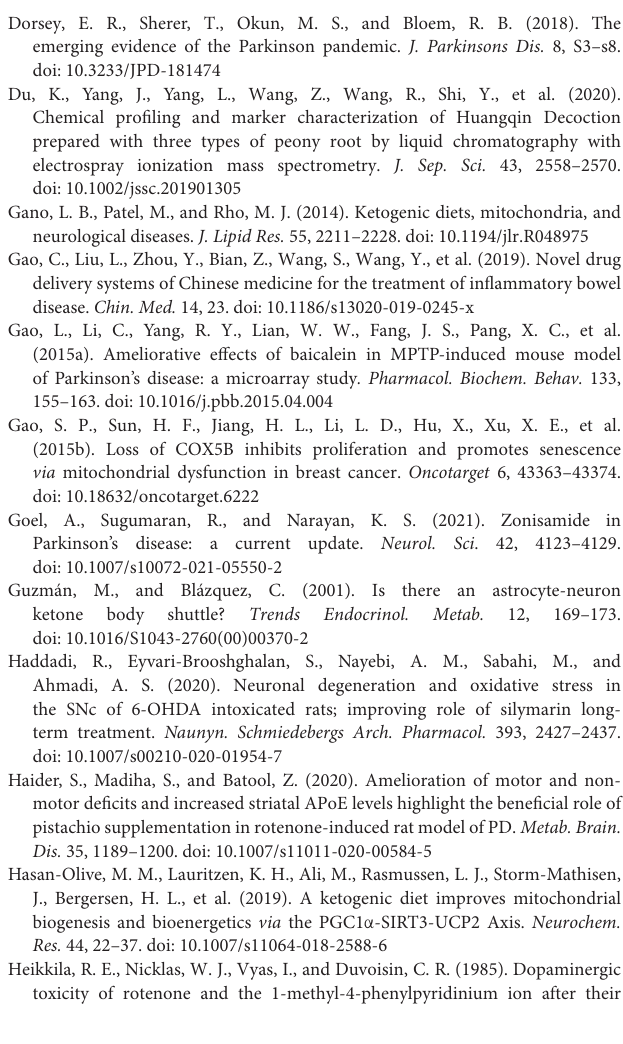
Supplementary Figure | The effect of HQD on pathological changes of brain tissue in rats with